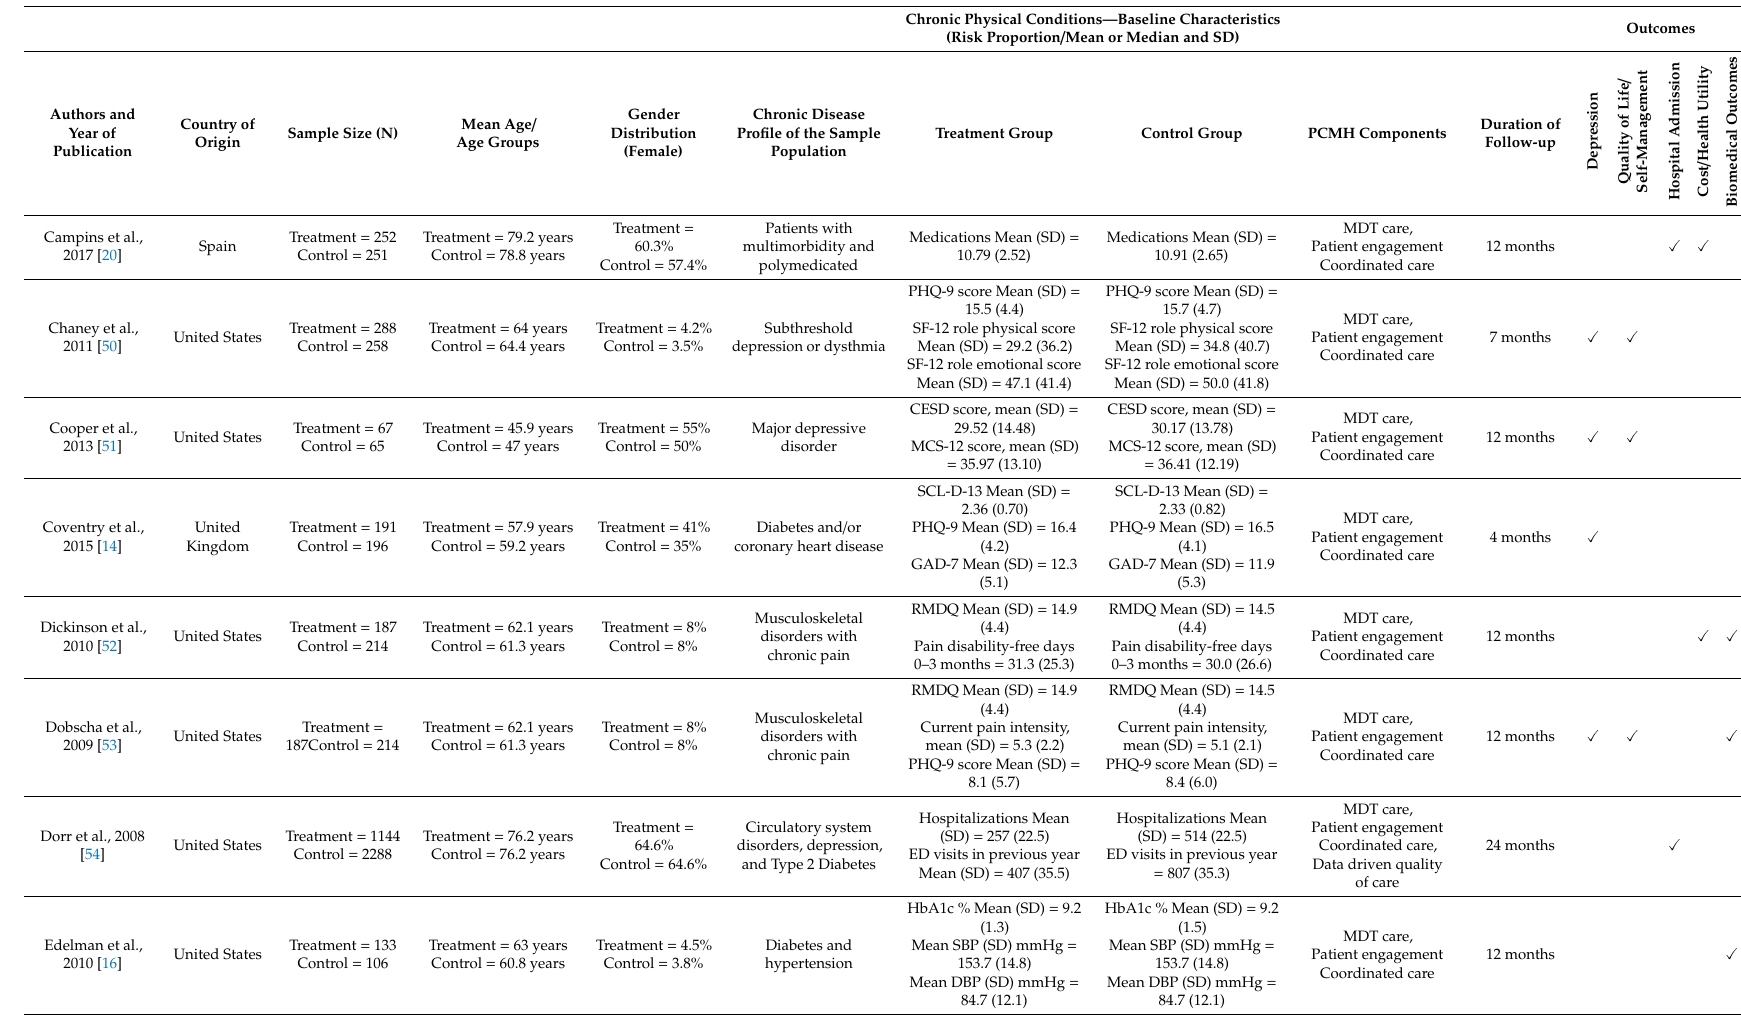
Table A3. Cont. Chronic Physical Conditions—Baseline Characteristics (Risk Proportion / Mean or Median and SD)